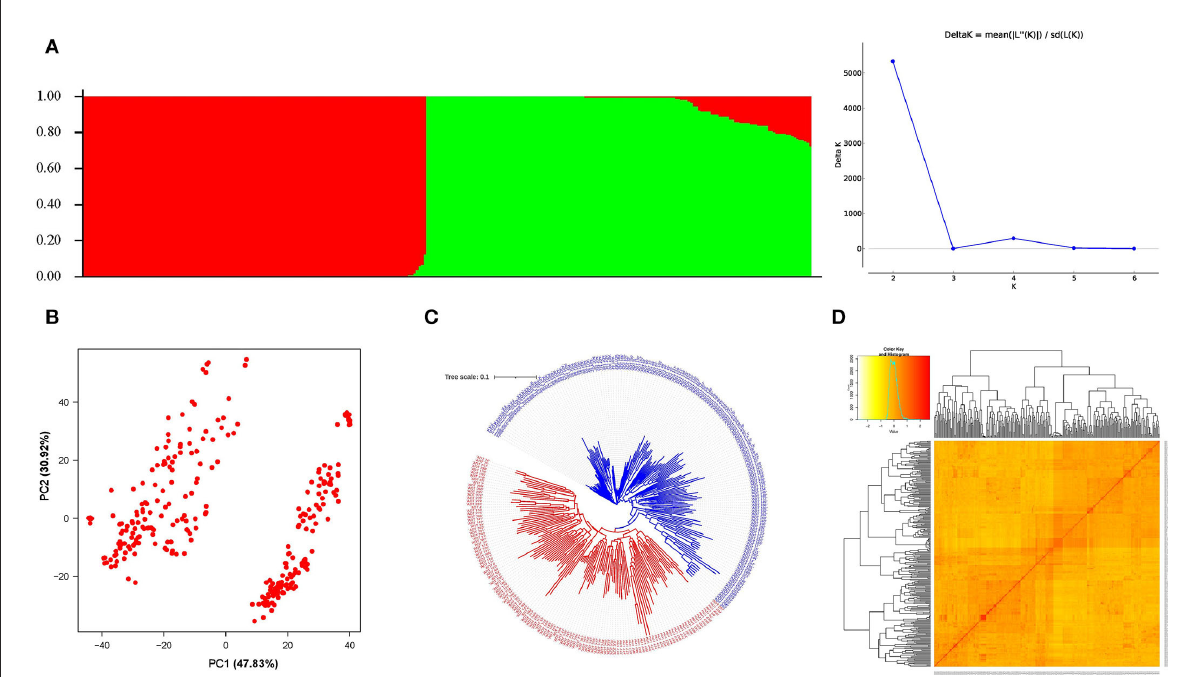
FIGURE4 Population groupings in the GWAS panel from different models. (A) Population structure-based grouping of genotype from STUCTURE analysis. (B) The 2D plot of the principal component-based grouping. (C) Neighbor-joining tree-based diversity. (D) Heat map of pair-wise kinship matrix.